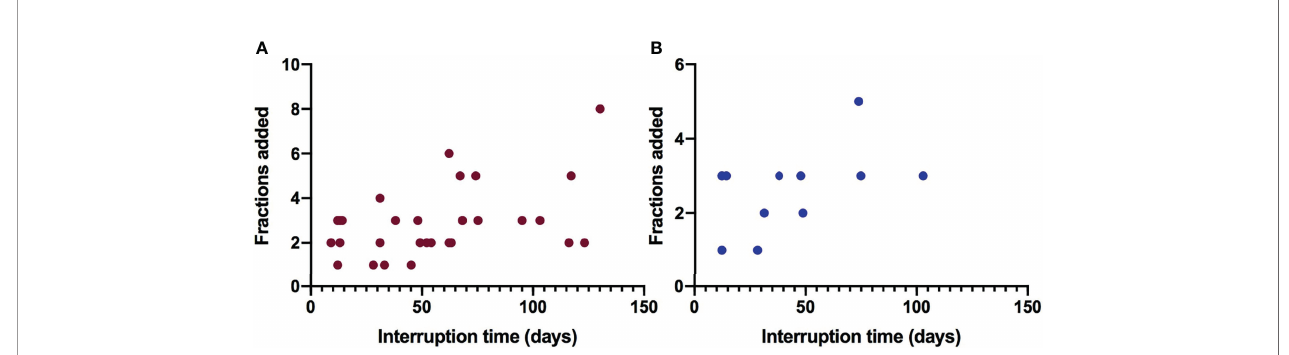
FIGURE 2 | The relationship between interrupted time and dose compensation fractions for patients with interrupted radiotherapy. (A) Dose compensation for all cancer patients with interrupted radiotherapy. (B) Dose compensation for nasopharyngeal cancer patients with